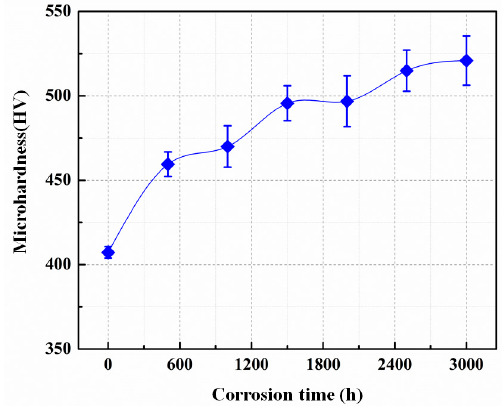
Figure 5. Surface microhardness of Ti 3 SiC 2 sample corroded by LBE for 500–3000 h.